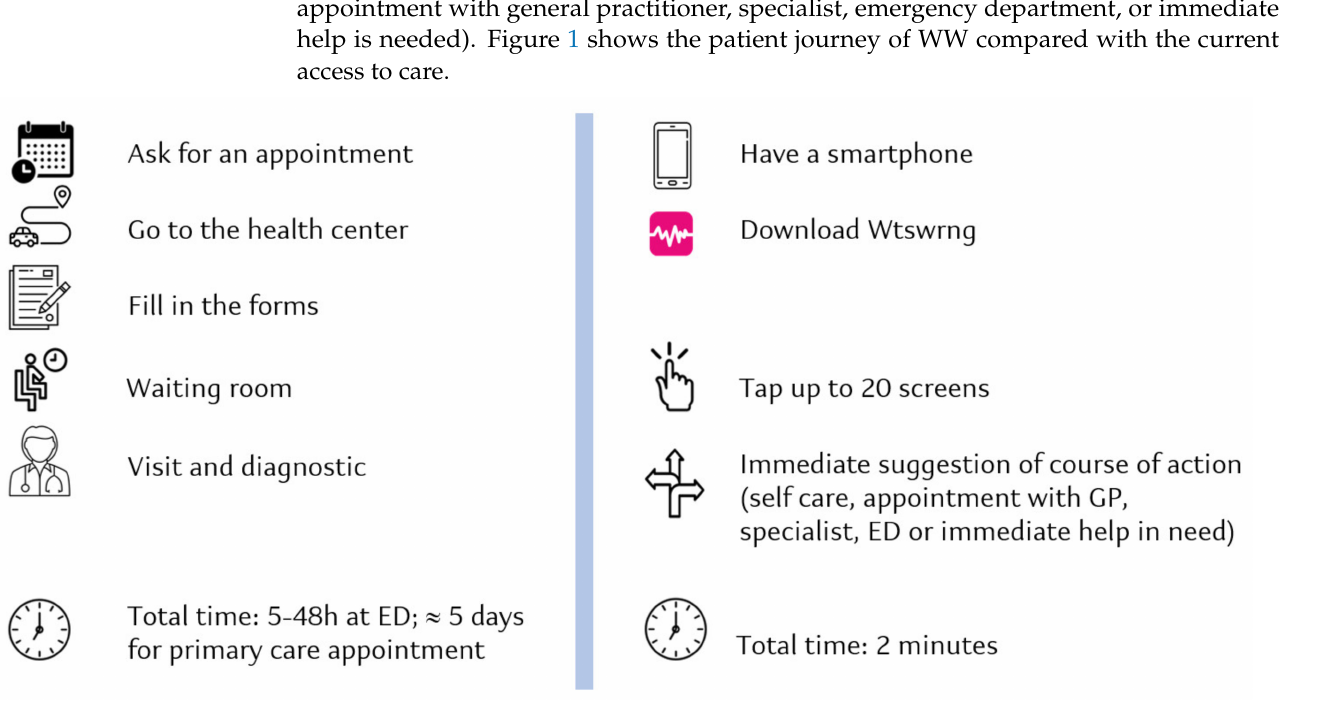
Figure 1. Patient journey: conventional care versus WtsWrng. ED: Emergency Department; GP: General